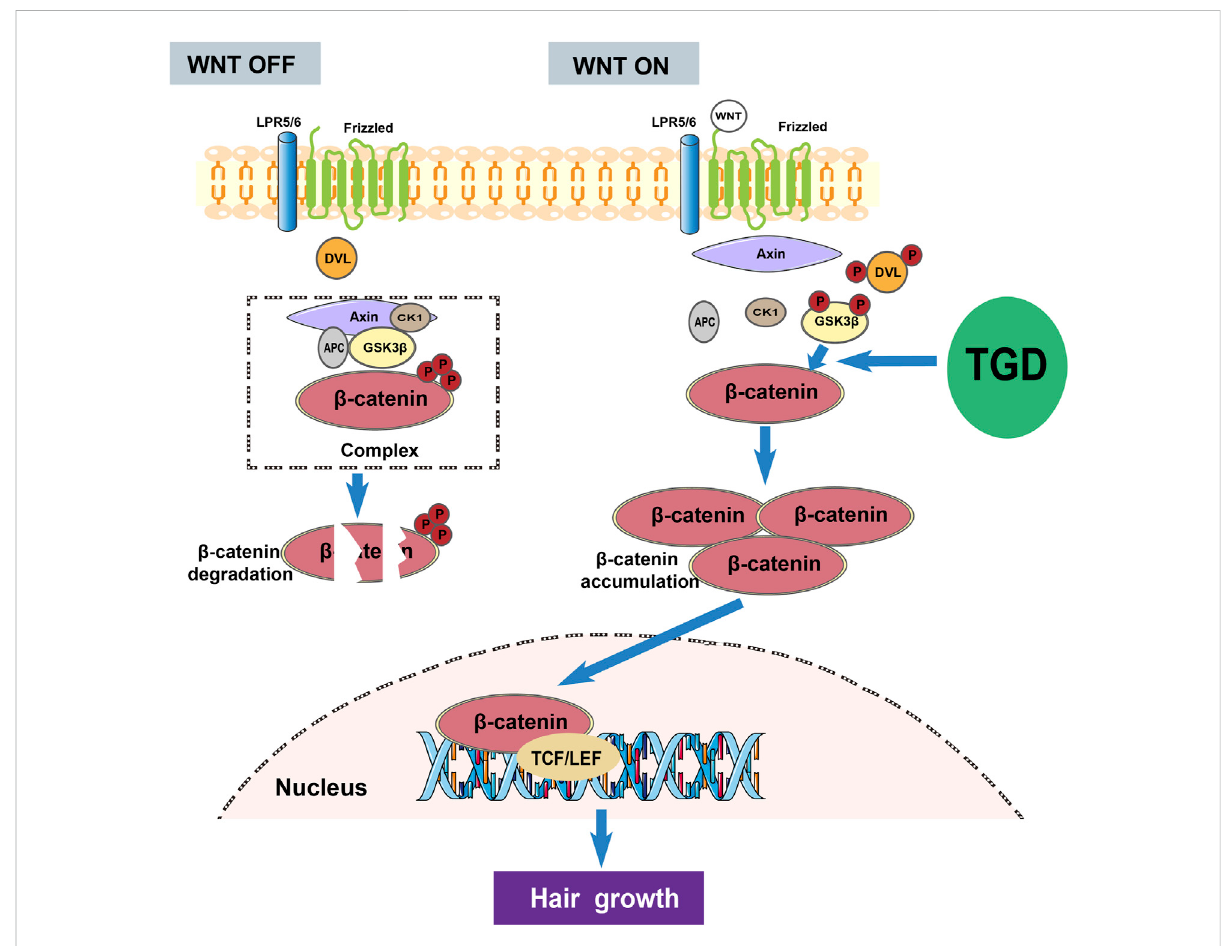
FIGURE 11 The overall mechanism diagram involved in the activation effect of TGD on hair